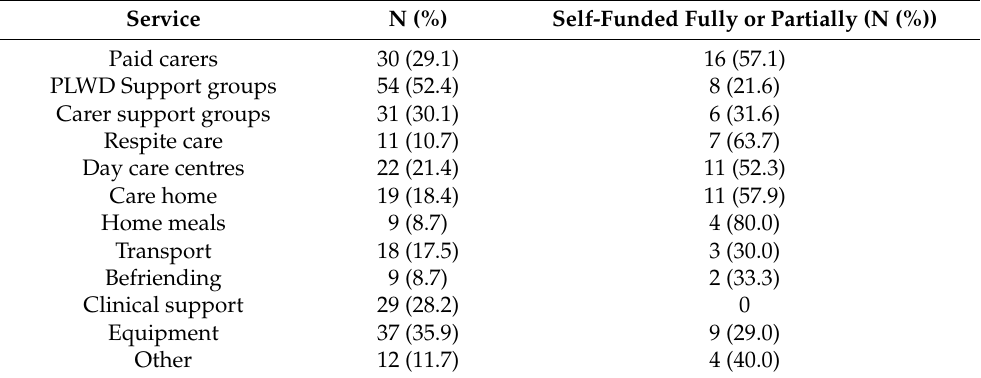
Table 2. Service usage.